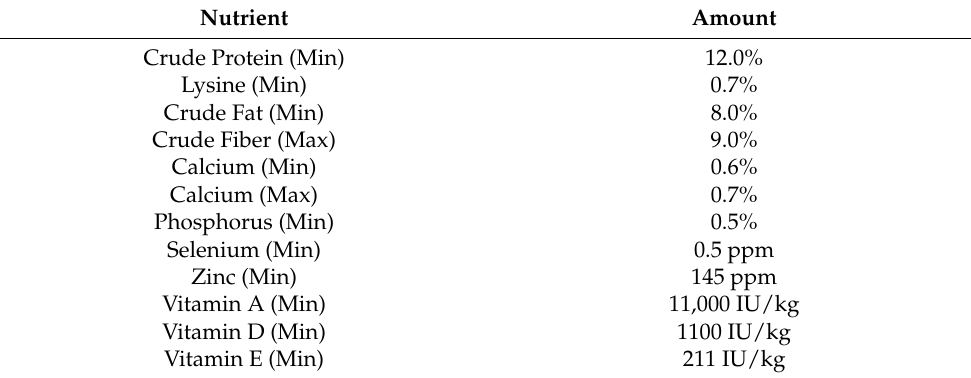
Table 1. Guaranteed analysis of the OBS Racing Blend concentrate provided to the horses throughout the study at 2.1 kg/500 kg body